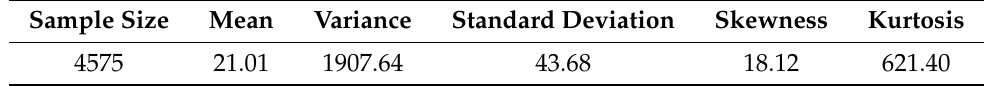
Table 4. Some basic statistical indicators of the original data x